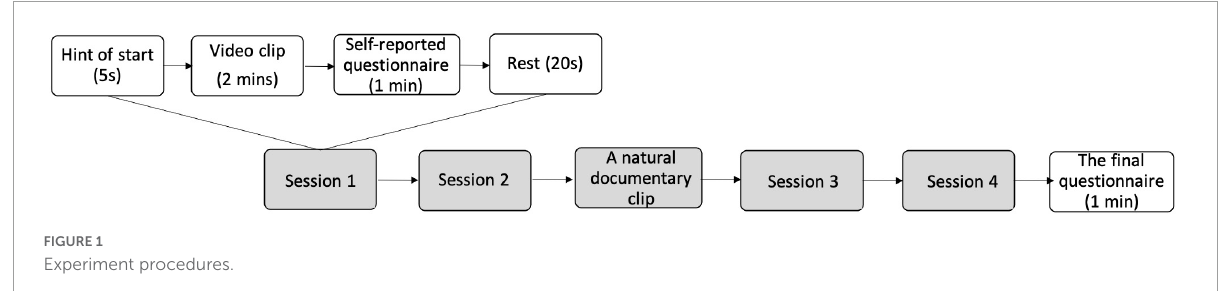
FIGURE1 Experiment